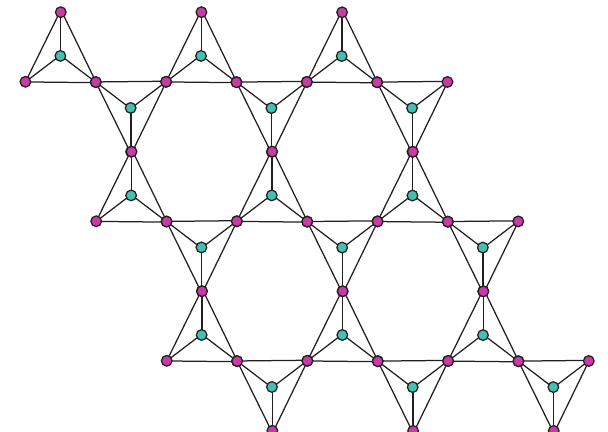
Figure 1: Graph of rhombus silicate network (RHSL ( t ) ).